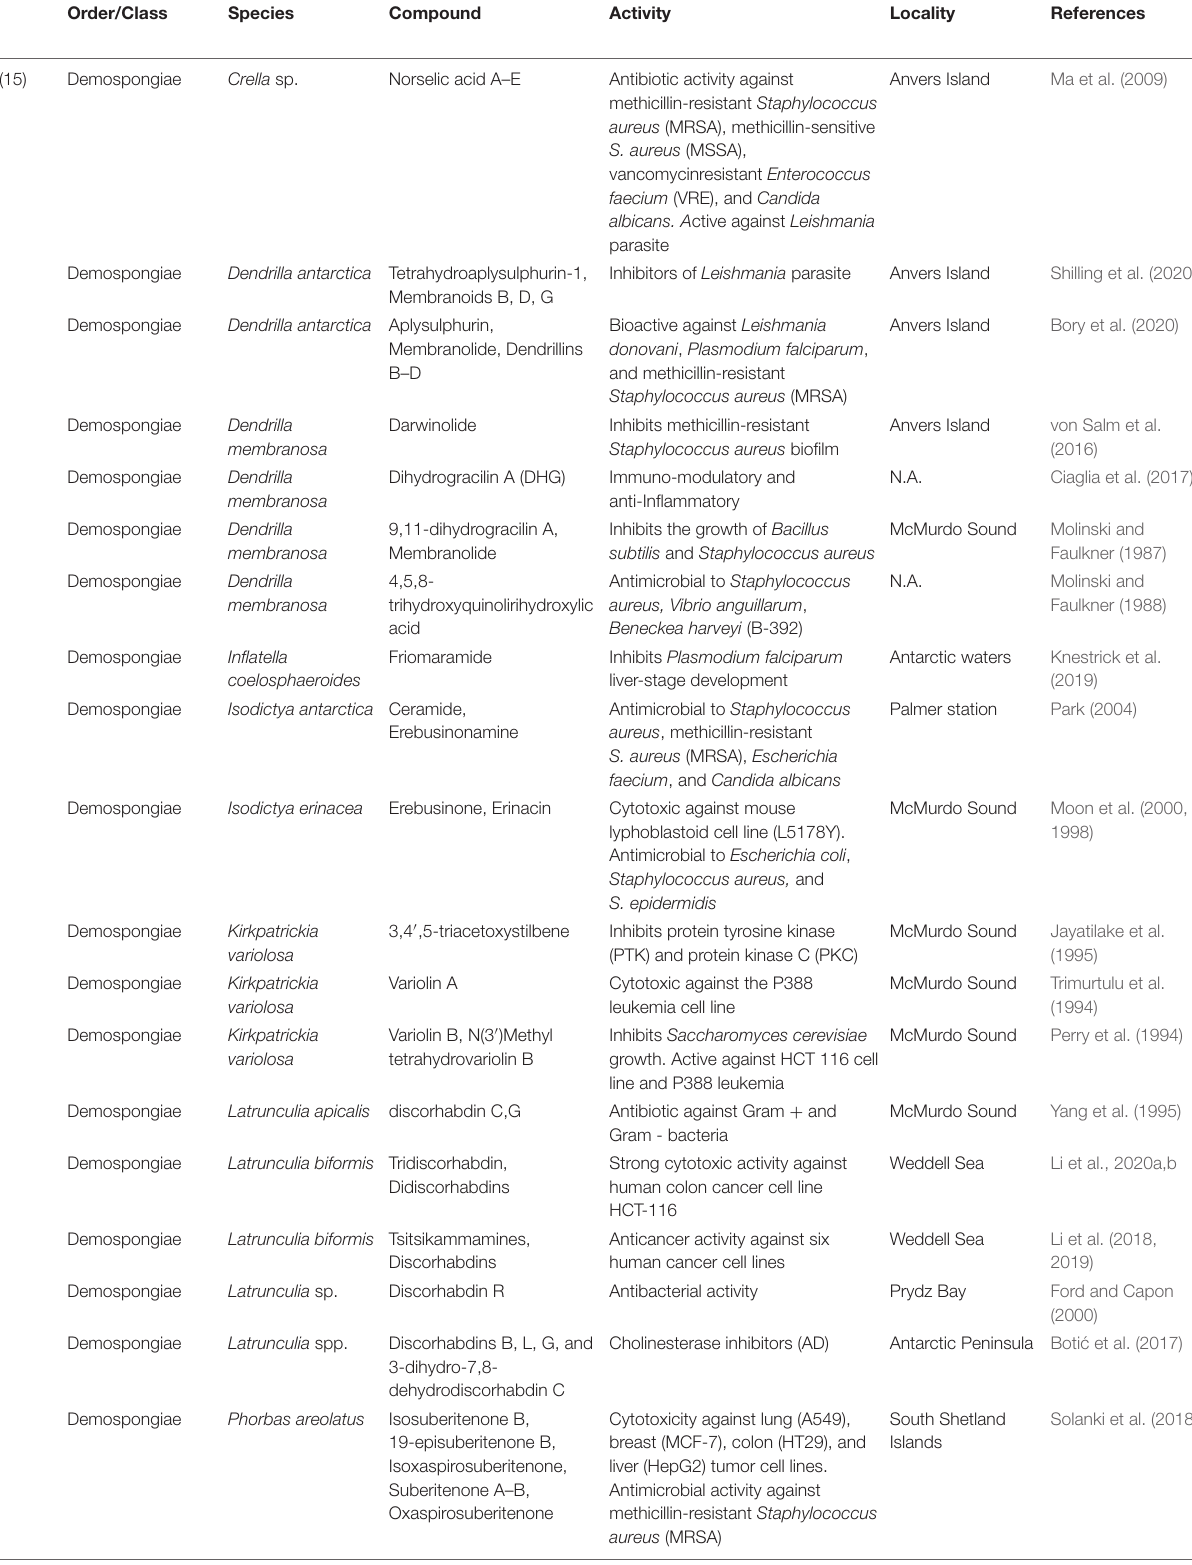
TABLE 1 | Brief summary of bioactive natural products from Antarctic marine benthic